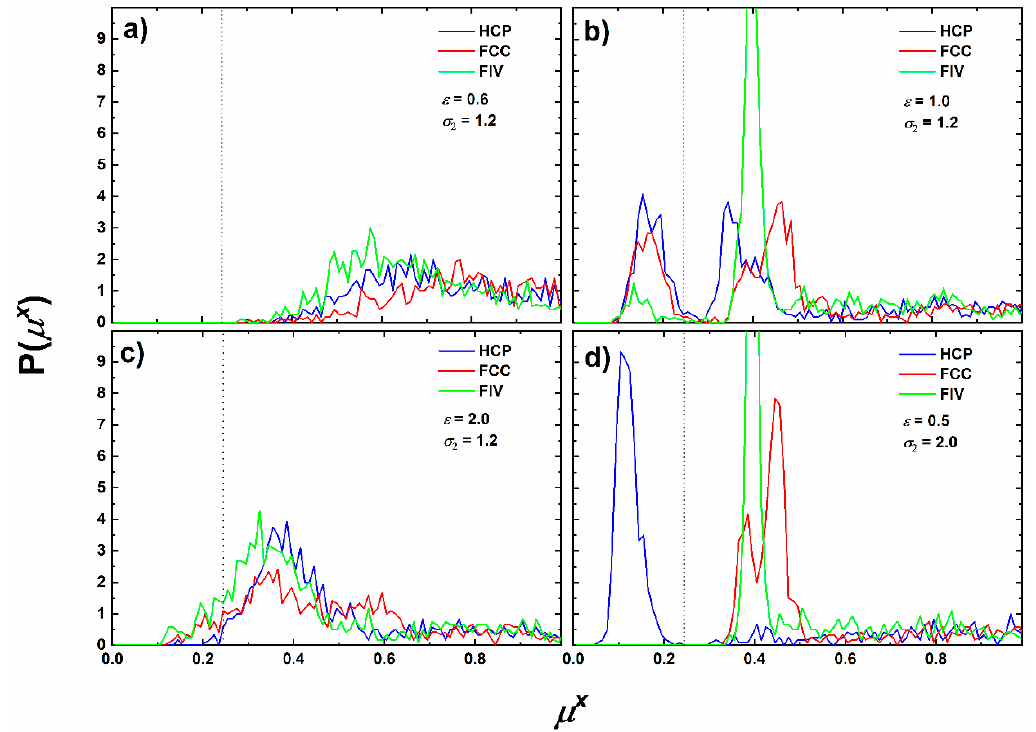
Figure 3. Probability distribution of the HCP- (blue), FCC- (red) and FIV- (green) CCE norm as obtained from structural analysis on the final system configuration for the SW chain systems: ( a ) ε = 0.6 and σ 2 = 1.2; ( b ) ε = 1.0 and σ 2 = 1.2; ( c ) ε = 2.0 and σ 2 = 1.2; ( d ) ε = 0.5 and σ 2 = 2.0. The vertical dotted line denotes the threshold value ( μ c = 0.245) for the identification of HCP, FCC or FIV local environments of non-overlapping spheres.